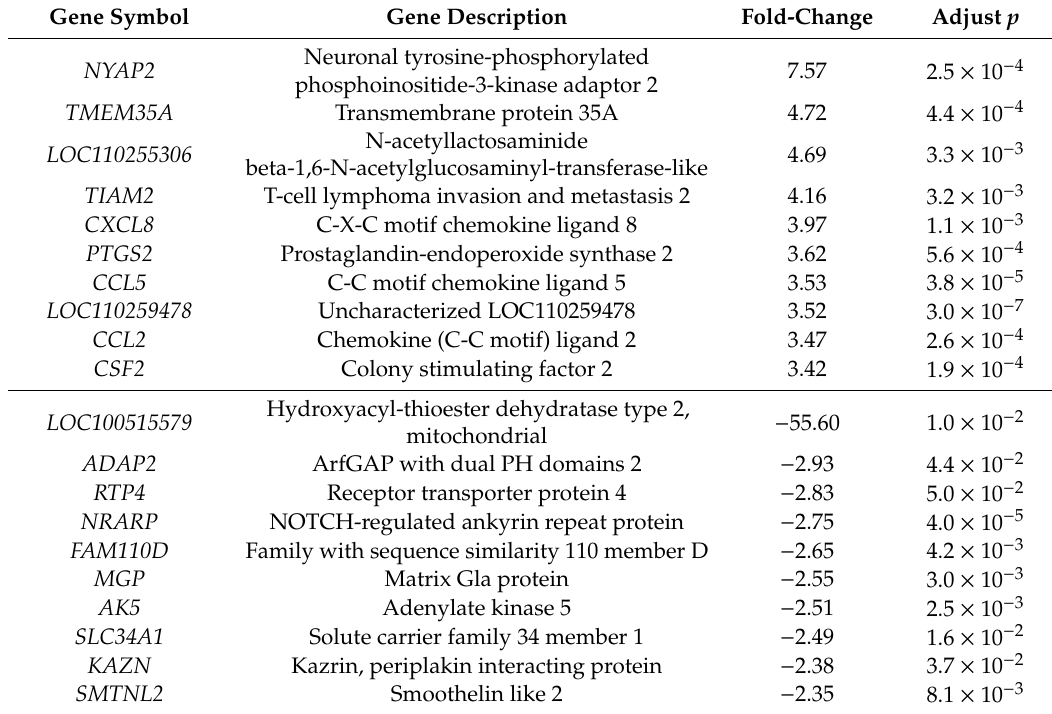
Table 1. Highly di ff erentially expressed genes in LPA treated swine macrophages vs. untreated swine macrophages.